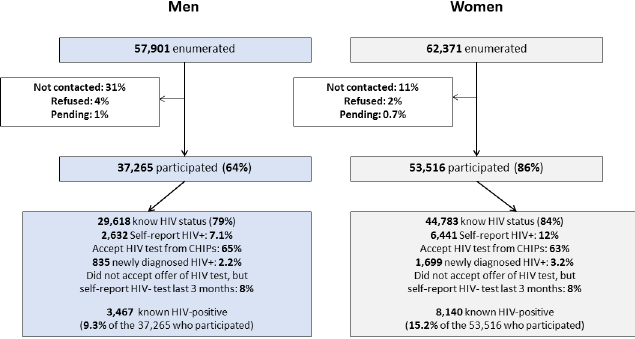
Fig 1. Enumeration, consent to participation, and knowledge of HIV status, in Round